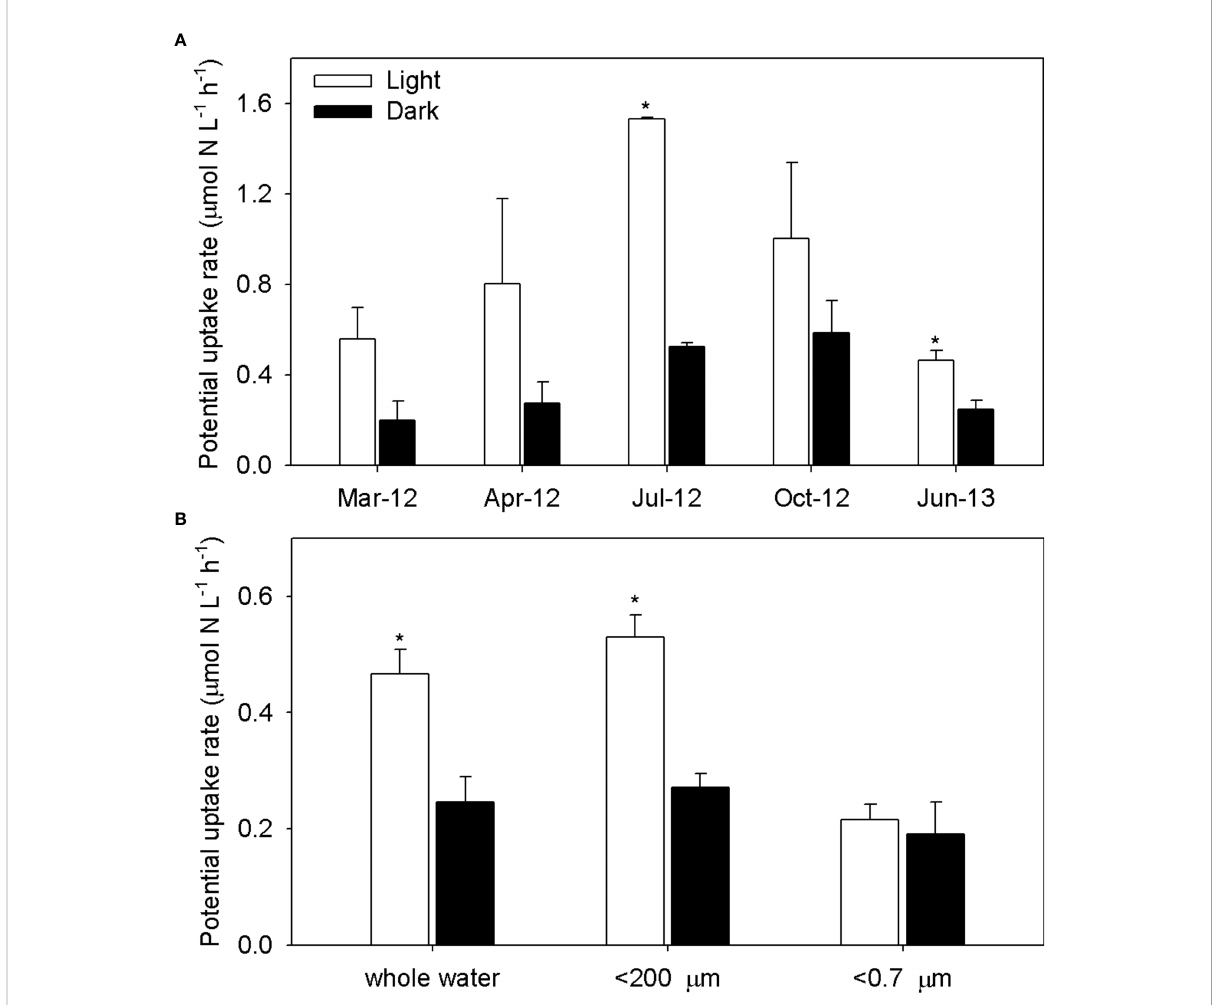
FIGURE 3 Ammonium potential uptake rates for whole-water samples (A) and size-fractioned (whole, <200 m m, and <0.7 m m) water samples (B) in light and dark treatments in the YRE. The * indicates a minimum value estimated from the initial ammonium concentration and regeneration rates in dark